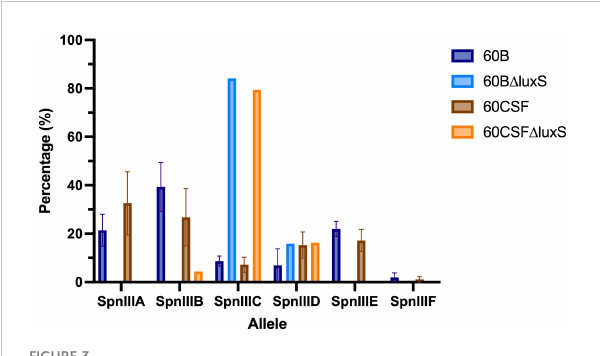
FIGURE 3 spnIII allele frequencies of 60B, 60CSF and luxS mutants. spnIII allele quanti fi cation was performed on DNA extracted from 60B, 60CSF, 60B Δ luxS and 60CSF Δ luxS colonies grown on BA plates overnight at 37°C with 5% CO 2 . Allele percentages are displayed for WT original inoculum (Figure 1) and luxS mutants from frozen